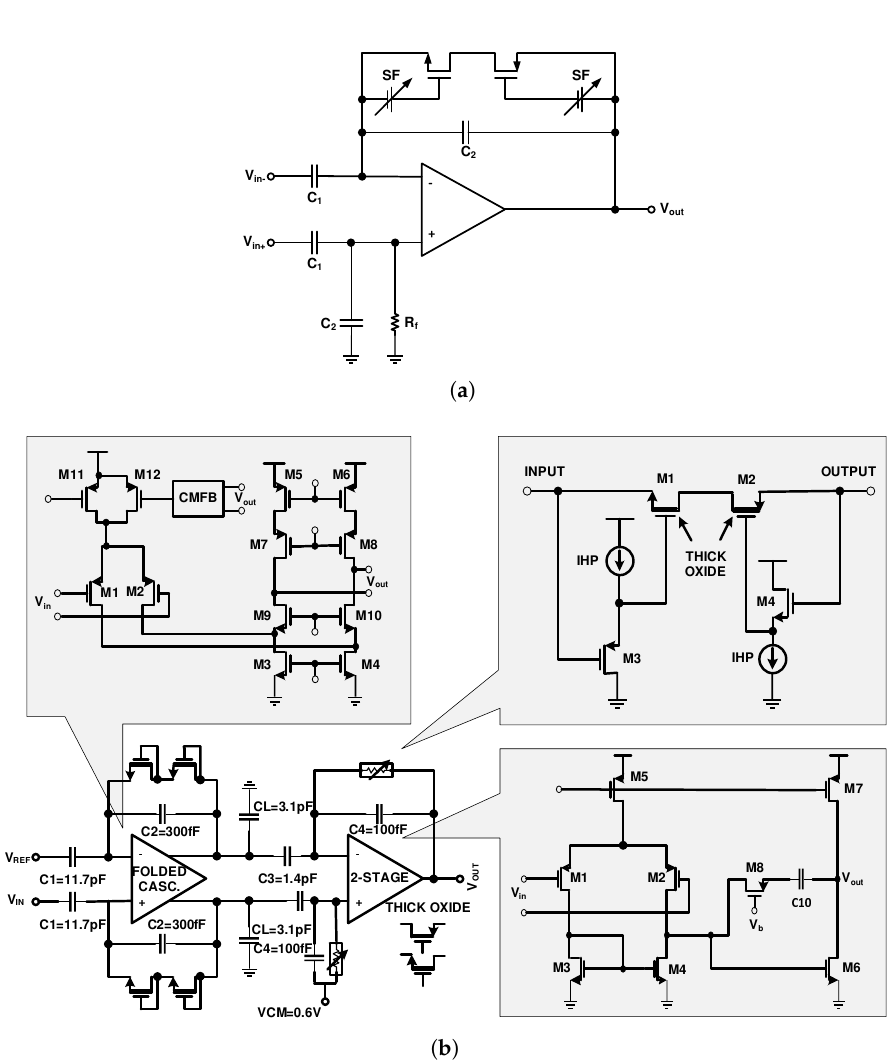
Figure 5. Improving the linearity of a CFN amplifier utilizing ( a ) source-followers (SF). ( b ) Two gain stages employing the proper NMOS and PMOS pseudoresistor and SFs.